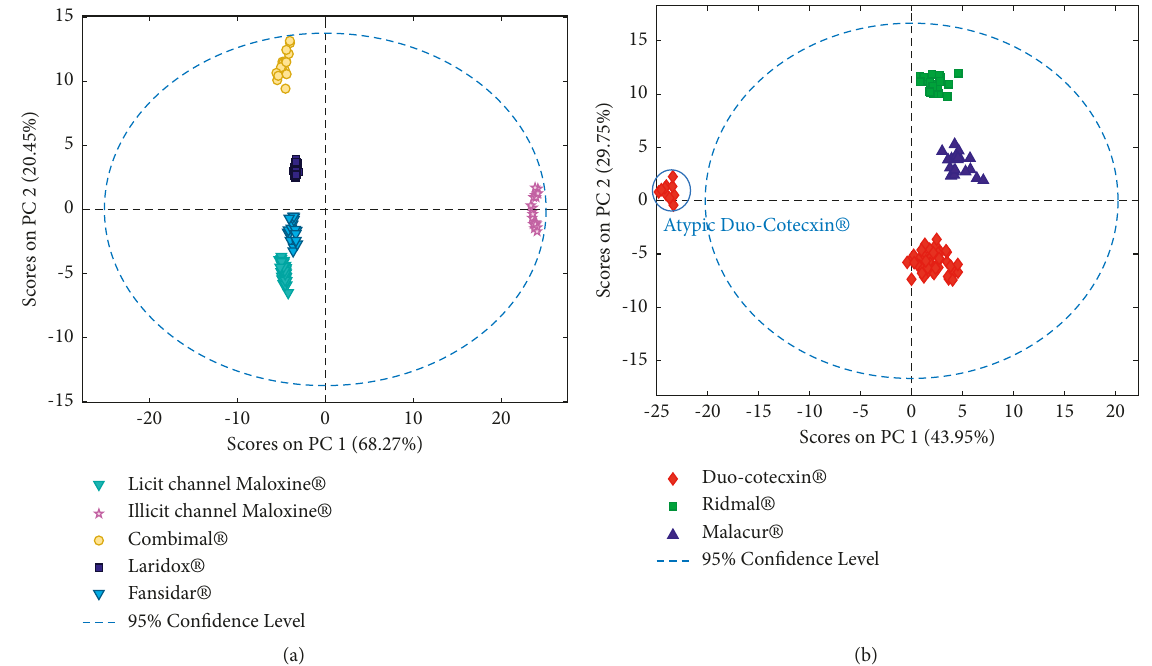
Figure 3: PCA applied separately on SP and DP preprocessed data. (a) SP PC1-PC2 score plot. (b) DP PC1-PC2 score plot.